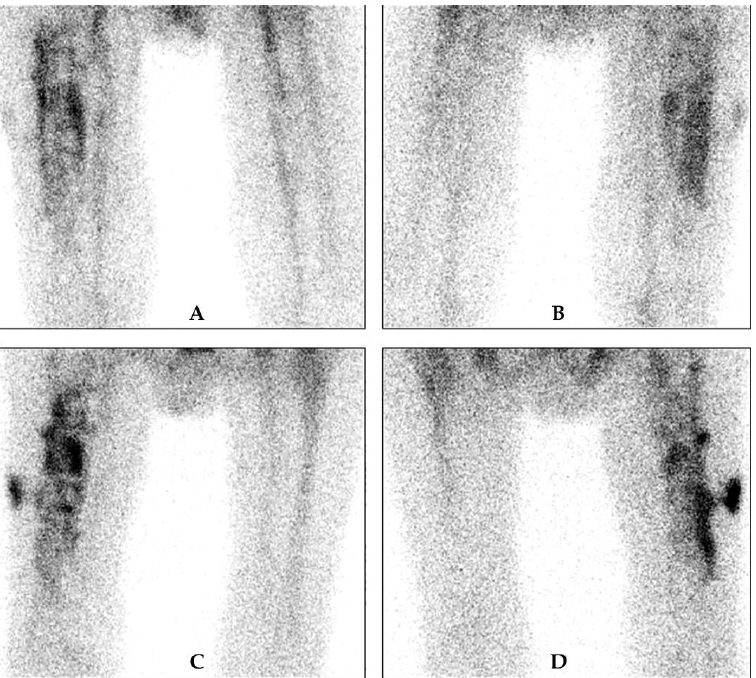
Figure 3. Example of 99m Tc- hexamethylene-propyleneamine oxime (HMPAO)-WBC scintigraphy in a patient with suspected PJI. Upper row: delayed images, ( A ) anterior and ( B ) posterior view, and lower row: late images, ( C ) anterior and ( D ) posterior view. There is increase in intensity and in size between the delayed and late images, which is very suspicious of a PJI. There is also extension of the infection to the peri-prosthetic soft tissue at the lateral side.